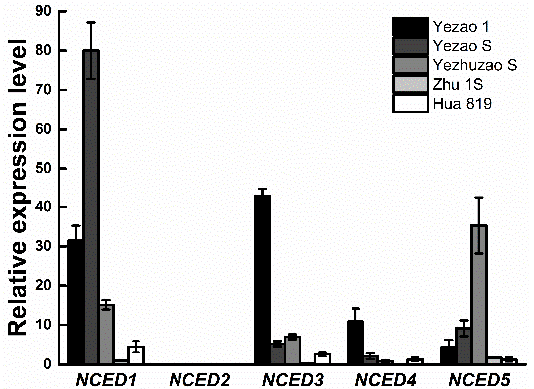
Figure 4. OsNCEDs expression of different rice lines.